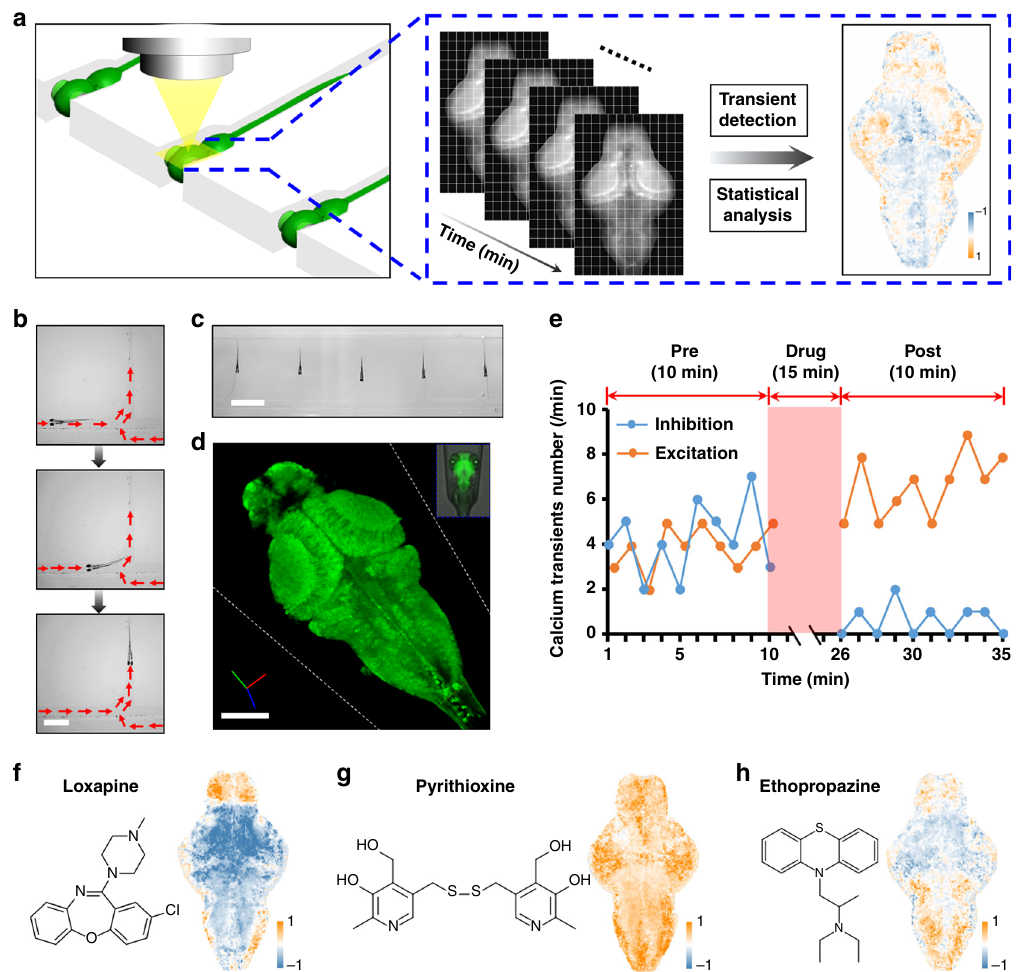
Fig. 1 High-throughput brain activity mapping (HT-BAMing) in zebra fi sh larvae. a Illustration of the HT-BAMing technology. b Image sequences showing the autonomous larva loading and immobilization in the micro fl uidic chip. Red arrows indicate the direction of the bulk fl ow. Scale bar, 2 mm. c Immobilization of multiple awake larvae in a micro fl uidic chip with a dorsal-up orientation. Scale bar, 5 mm. d Representative brain image of a larva (from elavl3 :GCaMP5G transgenic line) trapped in the system. Inset shows the merged image of the larva trapped in the chip. The white dotted line indicates the trapping channel. Scale bar, 100 µ m. e Representative curves showing the change of calcium fl uorescence fl uctuation in selected neuronal cells from a zebra fi sh brain. The sample showing inhibition was treated with the typical antipsychotic loxapine, while the sample data showing excitation follows treatment with pyrithioxine. f − h T-score BAMs showing the regulation of brain physiology induced by different CNS drugs including f loxapine, a dibenzoxazepine-class typical antipsychotic; g pyrithioxine, a synthetic, dimeric, disul fi de bridged, derivative of vitamin B6 (pyridoxine) with